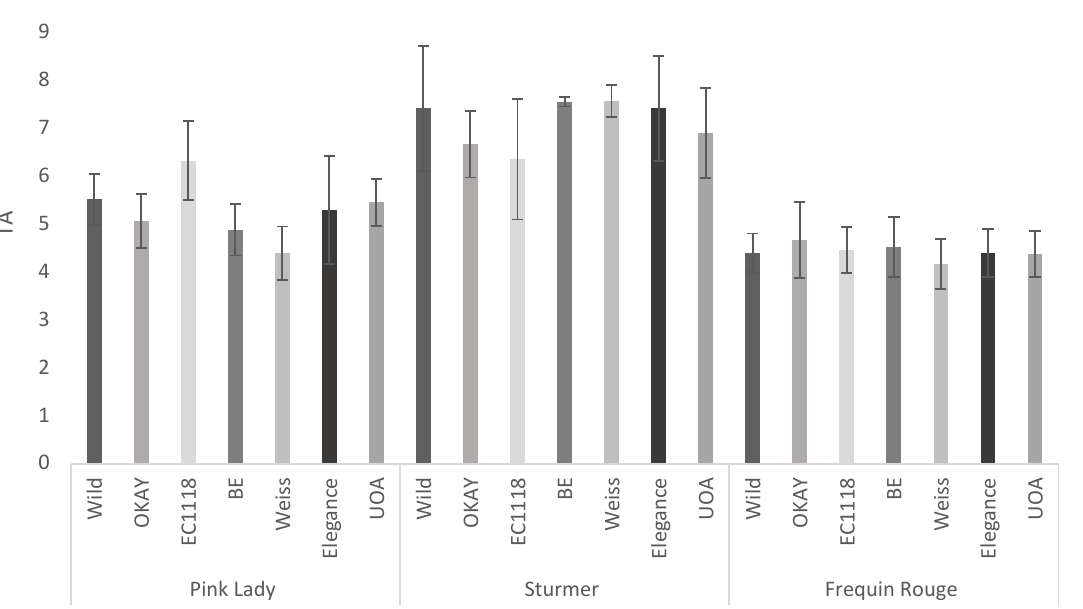
Figure 2. Titratable Acidity (TA) of cider made by each yeast strain for all three apple varieties in 2019.